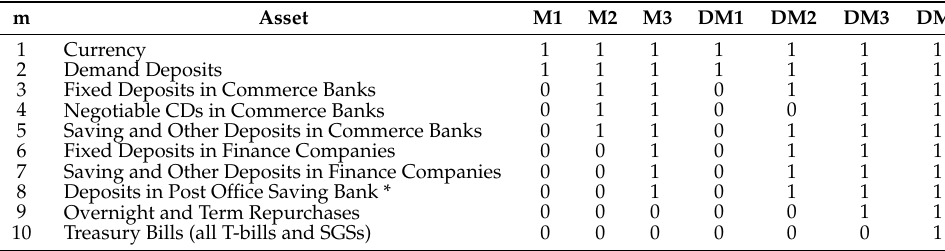
Table 2. Nesting Components in Monetary